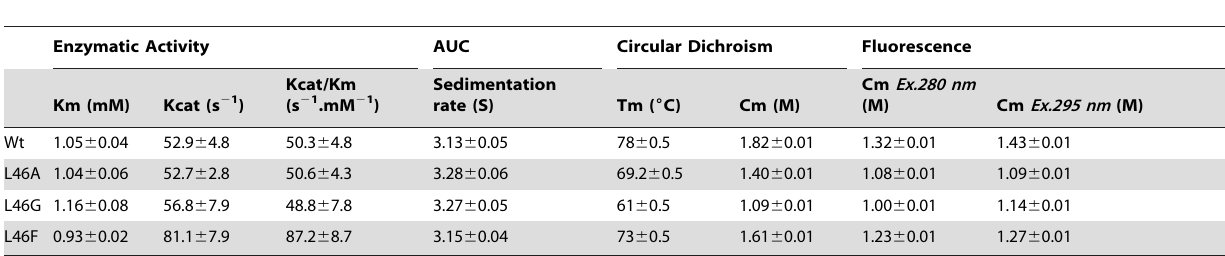
Table 1. Summarized enzymatic and biophysical data collection of wt and Leu46 huMIF mutants.